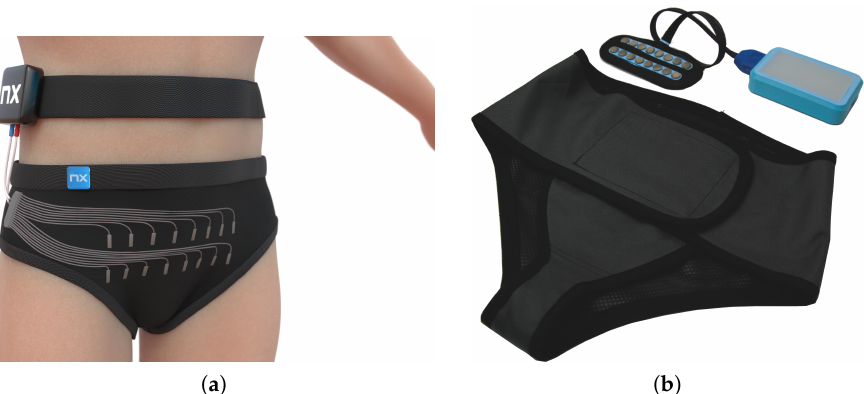
Figure 1. Panel ( a ) shows a visualization of an innovative device for measuring EIT and EMG with a module for muscle electrostimulation. Panel ( b ) presents a prototype of a wearable EIT measurement system with skin-safe sensors and a comfortable to-carry recording